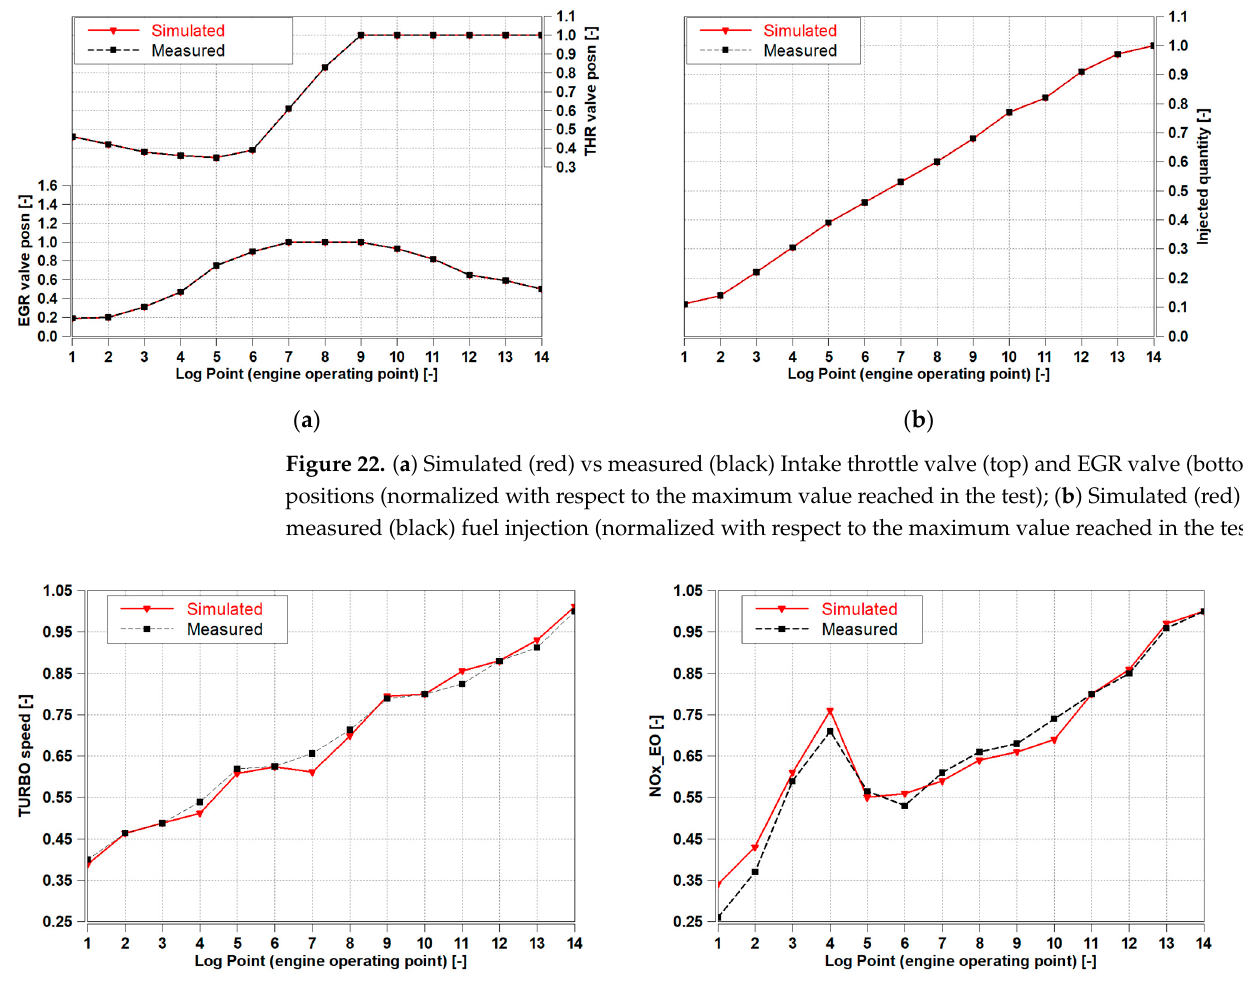
Figure 22. ( a ) Simulated (red) vs measured (black) Intake throttle valve (top) and EGR valve (bot- tom) positions (normalized with respect to the maximum value reached in the test); ( b ) Simulated (red) vs measured (black) fuel injection (normalized with respect to the maximum value reached in the test).